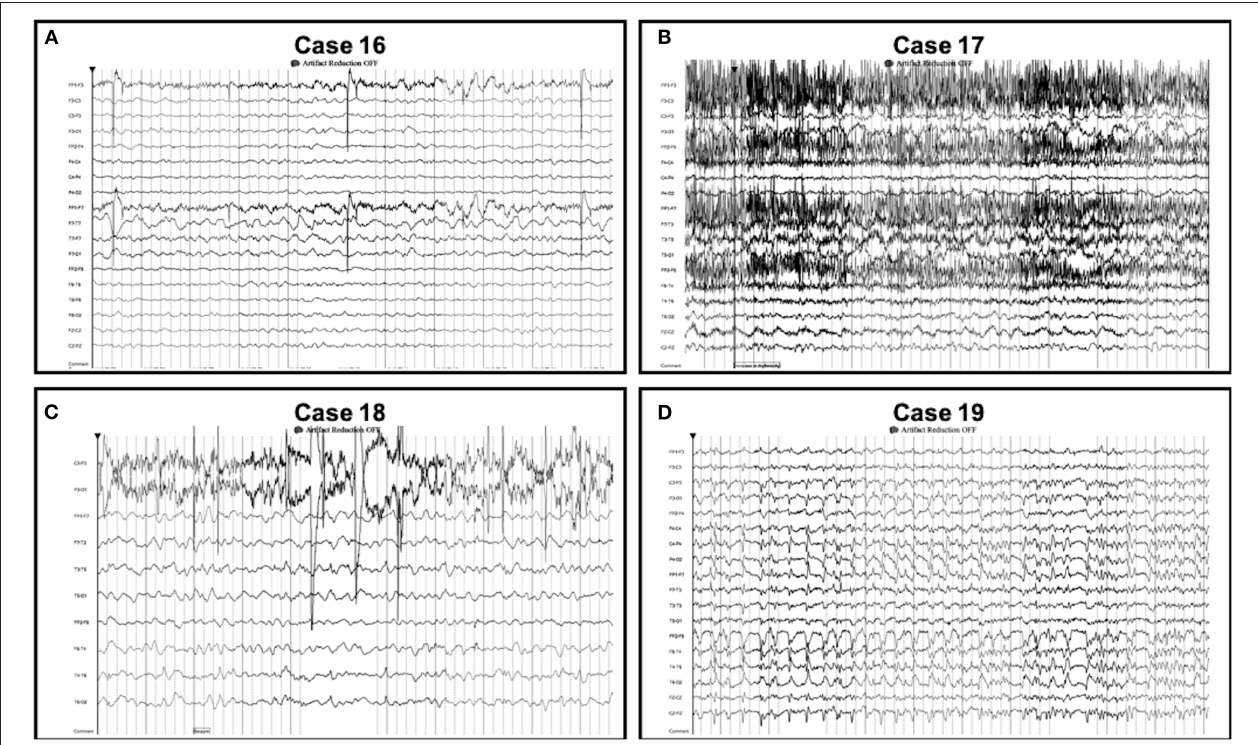
FIGURE 3 | Seizures detected on conventional EEG only. Seizures detected on conventional EEG (but not Rapid-EEG ) in cases 16–19 were not restricted to the midline or parasagittal regions. Individual case descriptions corresponding to panels (A–D) are provided in Supplementary Data